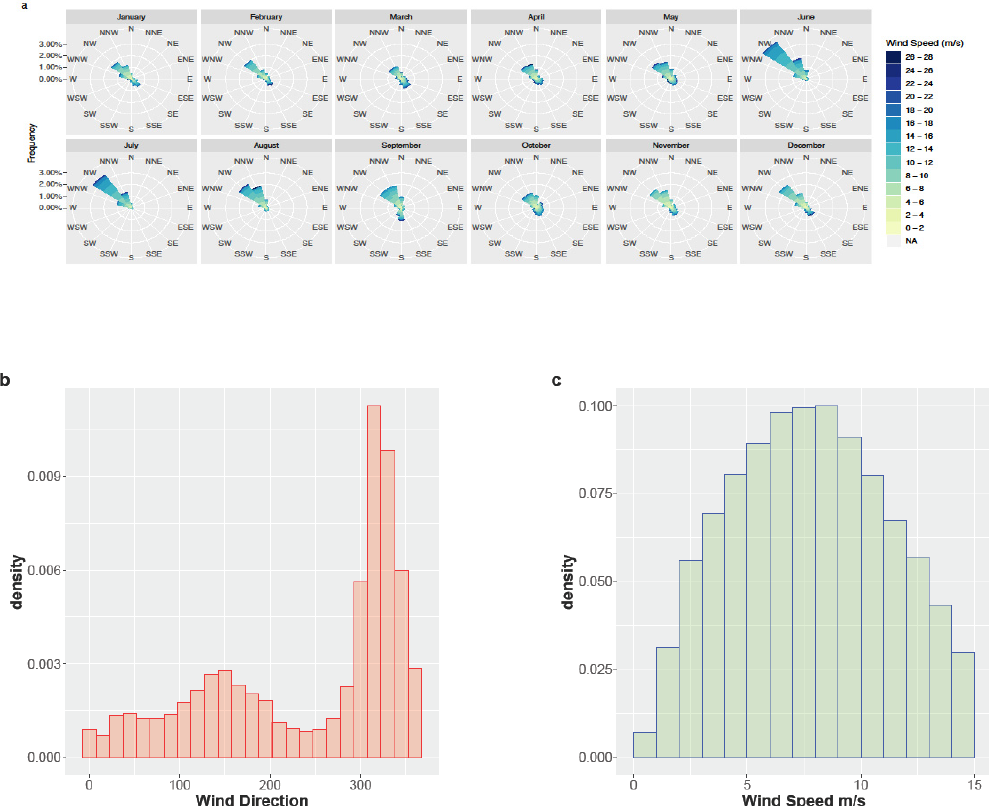
Figure 6. Mean annual daily wind observations from Shagaya Renewable Energy Park as: ( a ) wind roses of speed and direction by month; and frequency distributions of ( b ) wind direction and ( c ) wind speed.